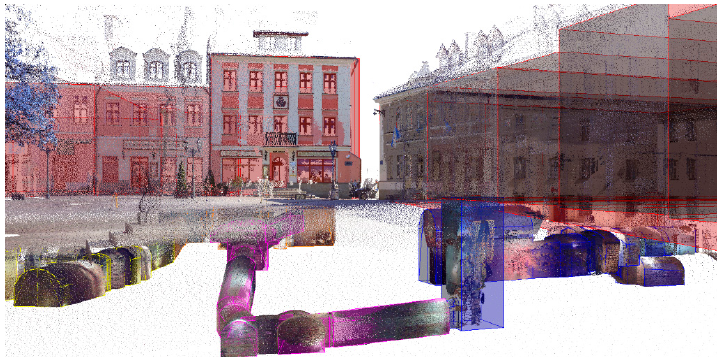
Figure 19. The point cloud of the Underground Tourist Route and the Main Market Square coloured by RGB values with the surface model. RGB values with the surface